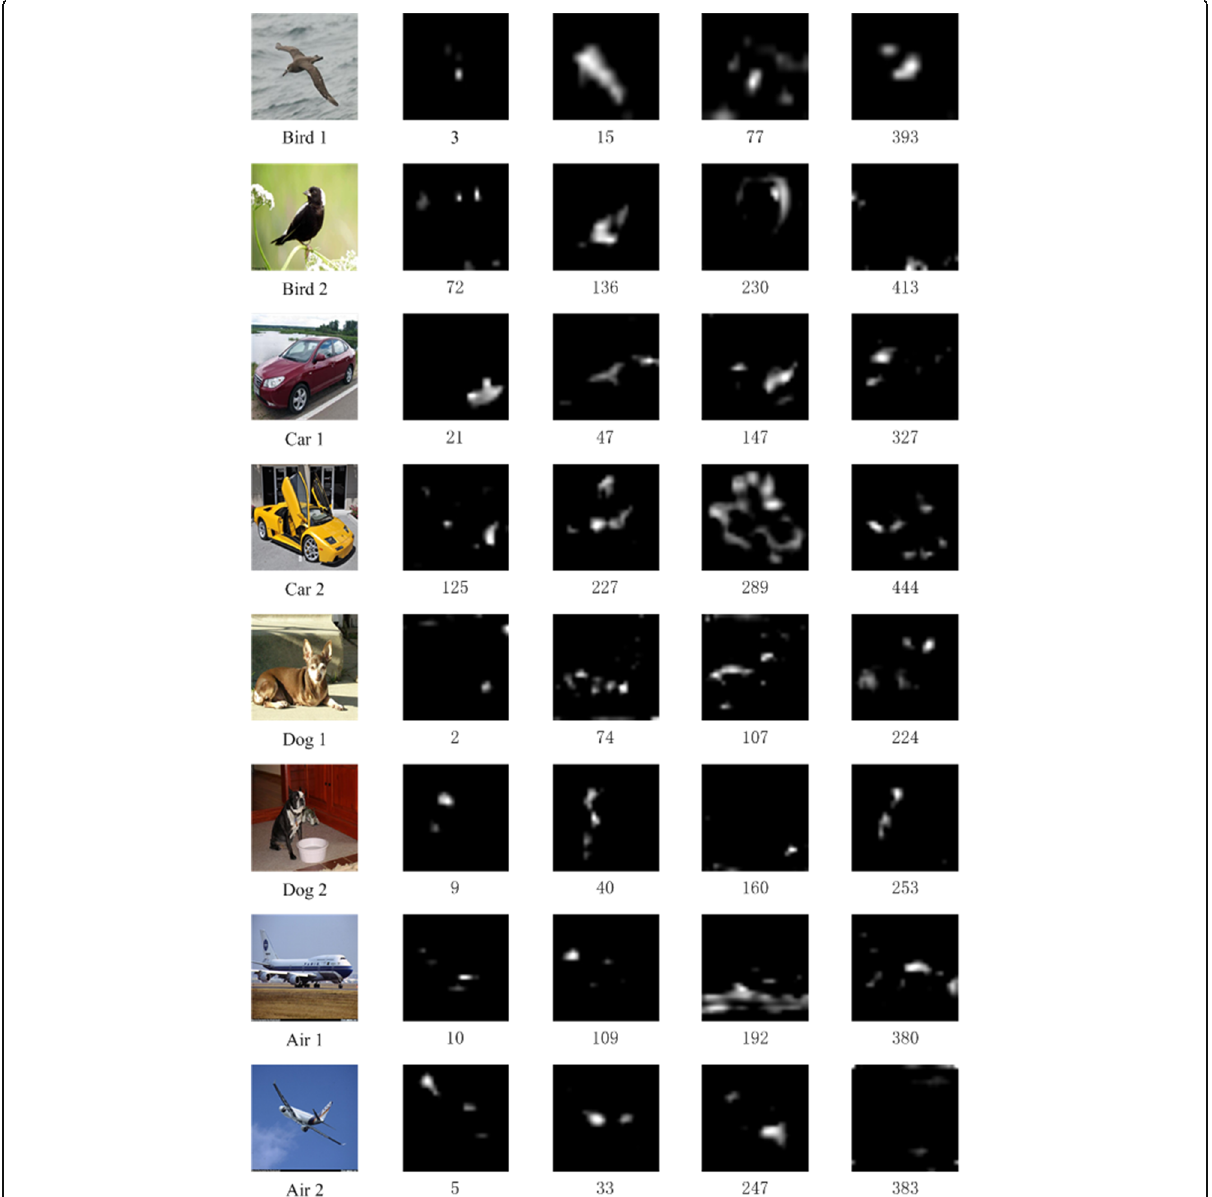
Fig. 3 Examples of several images sampled from four datasets [26 – 28] evaluated in this paper and picked corresponding visualized feature maps the digits below which are the index of